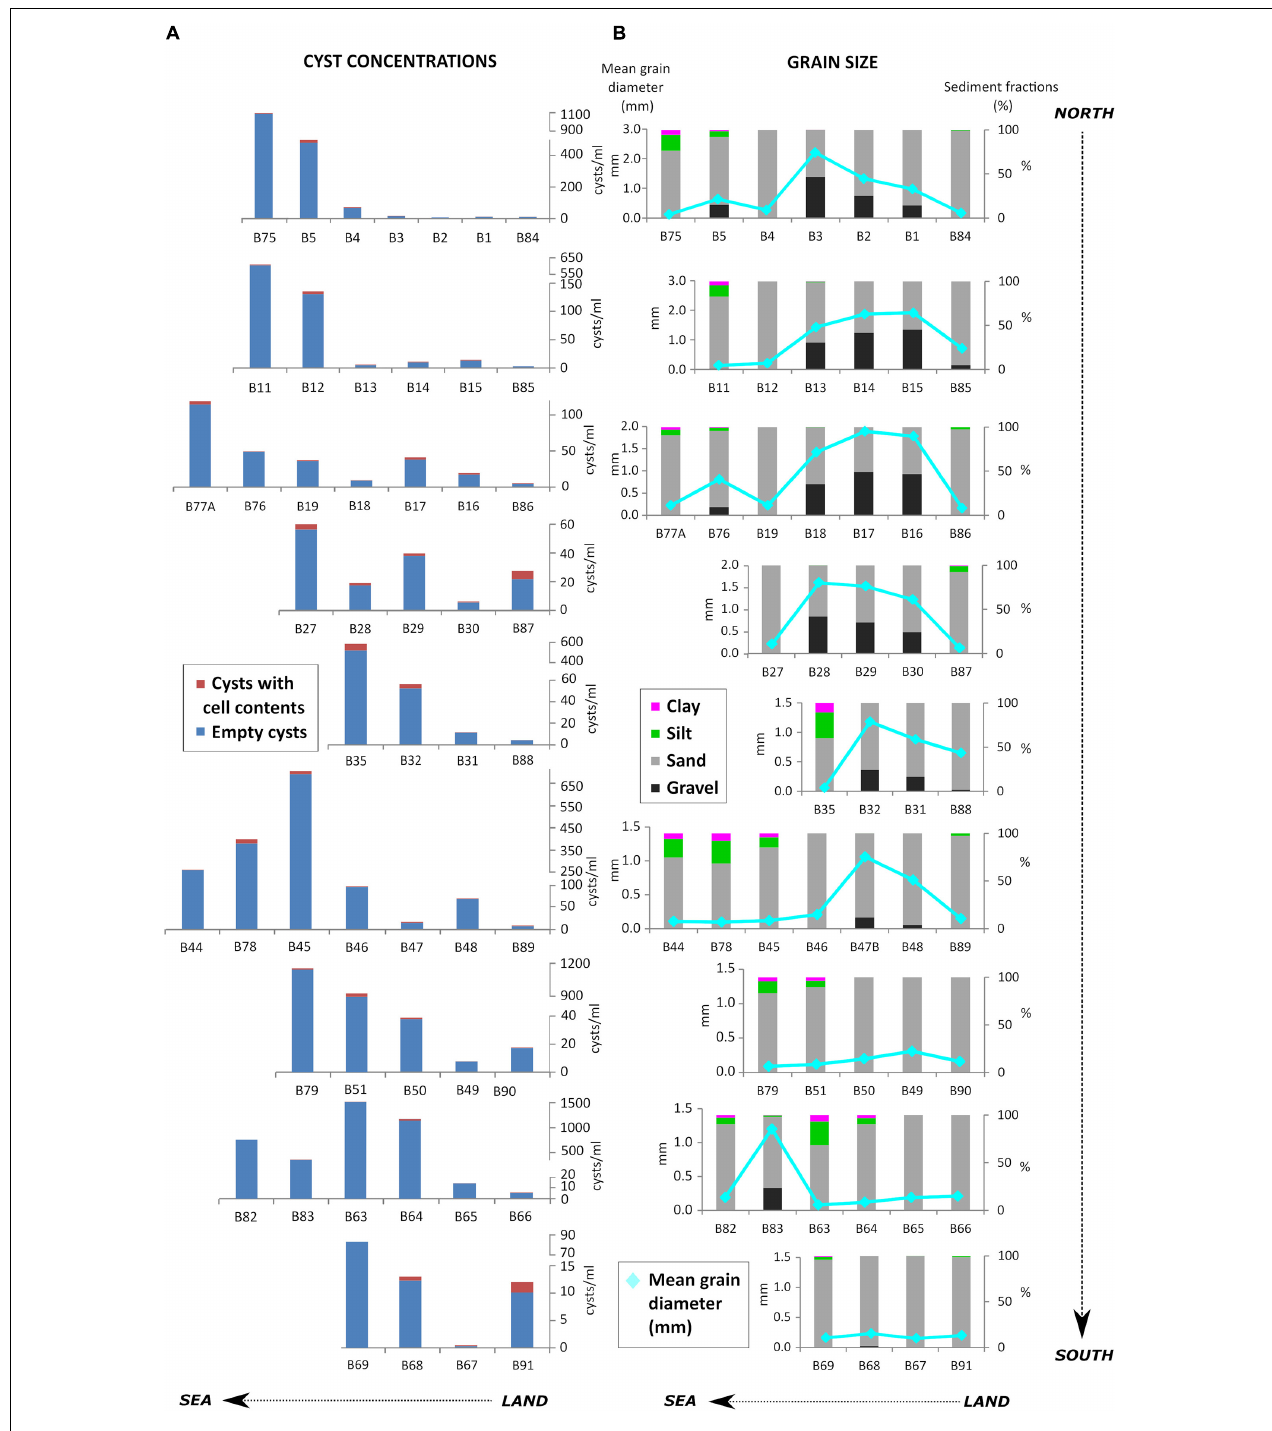
FIGURE 2 | Spatial distribution of cysts (empty cysts and cysts with cell contents) (cysts . ml − 1 ) (A) and sediment grain size (B) along the nine transects studied.